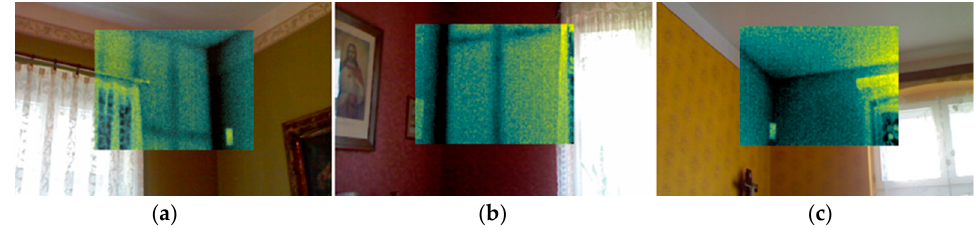
Figure 7. Thermogram of half-temperature distribution in the external front wall, insulated from the inside with 10 cm mineral wool and finished with plasterboards, ( a ) south-west corner of the first floor, ( b ) south-east corner of the second floor, ( c ) north-west corner of the second floor with an attic ceiling insulated from the outside on both sides with a layer of 10 cm foamed polystyrene.